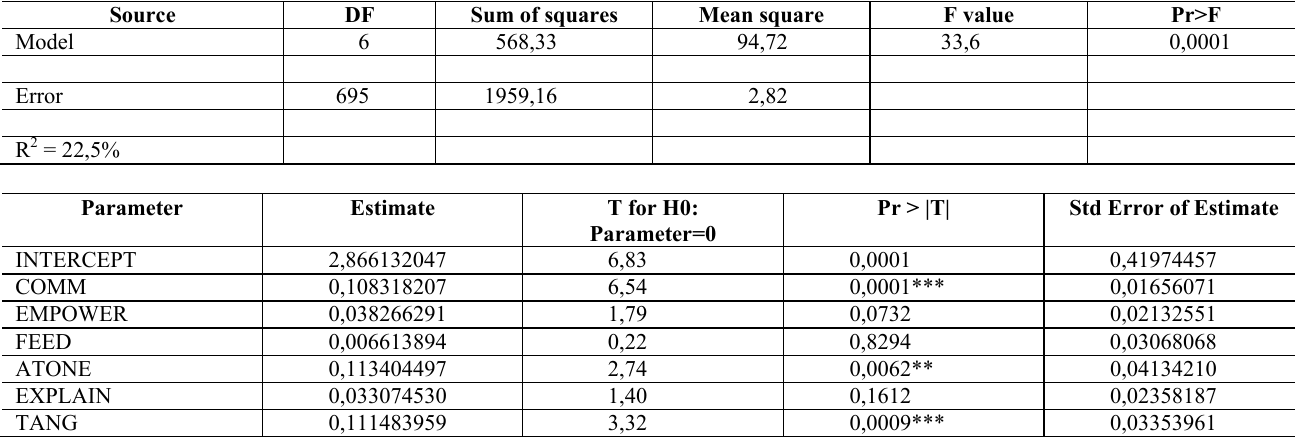
Table 8: Multiple regression results: